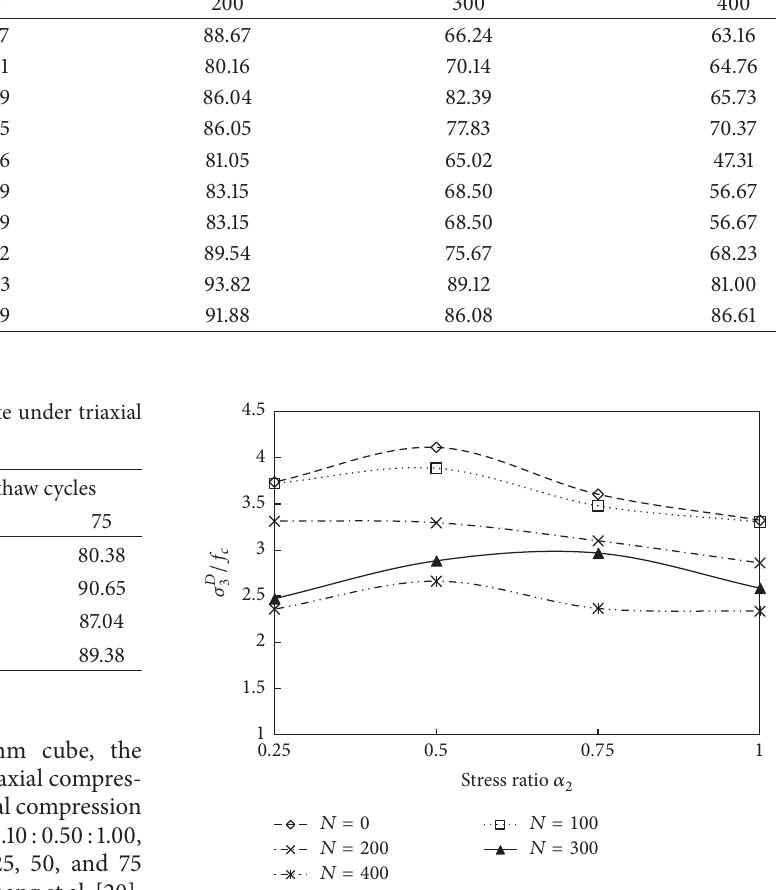
Figure 3: Influence of middle stress ratio 𝛼 2 on triaxial compressive strength after rapid freeze-thaw